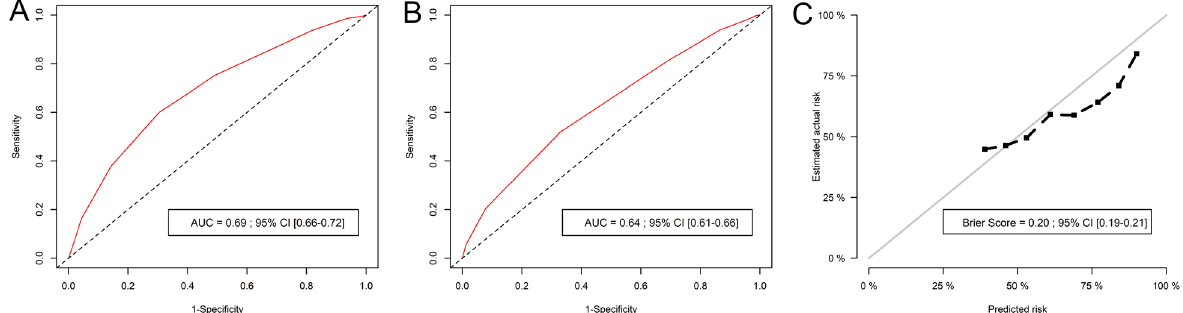
Fig. 2 Receiver operating characteristics curves for the CVC‑IN score in the a training and b testing cohorts and c calibration plot in the testing cohort. CI confidence